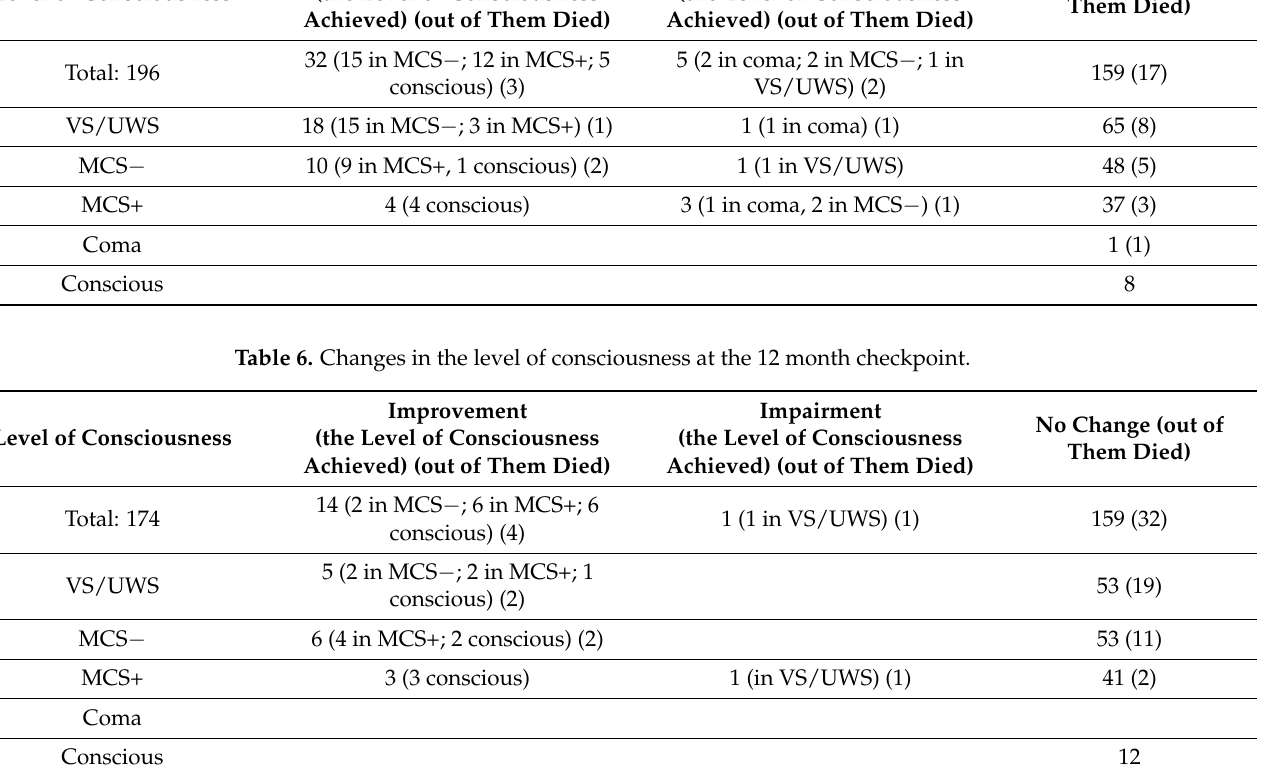
Table 5. Changes in the level of consciousness at the 6 month checkpoint.